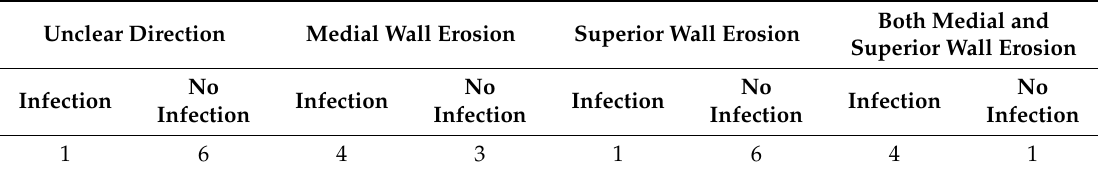
Table 5. Direction of erosion and infections.